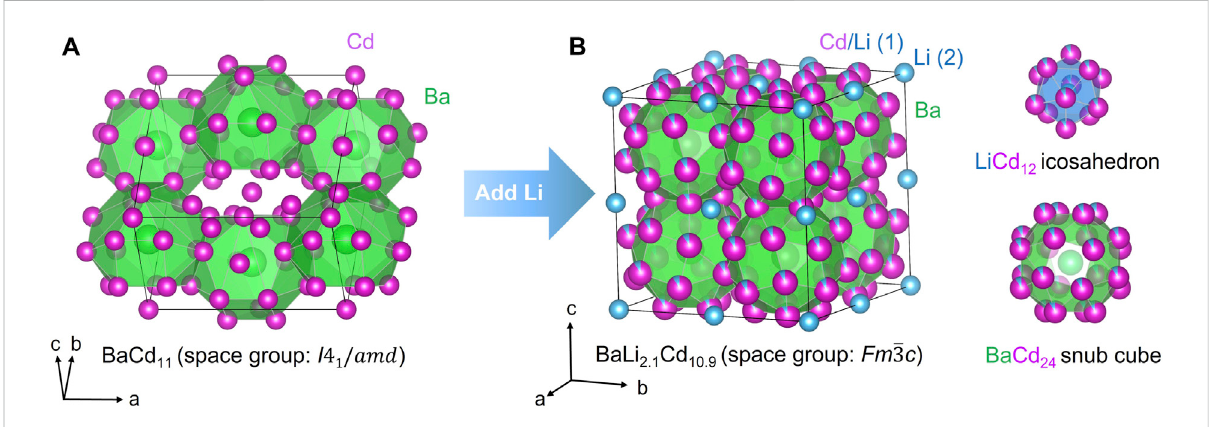
FIGURE 1 (A) BaCd 11 crystallizes in a tetragonal structure type. It cannot transition to the cubic NaZn 13 structure even with the presence of excessive Cd. (B)